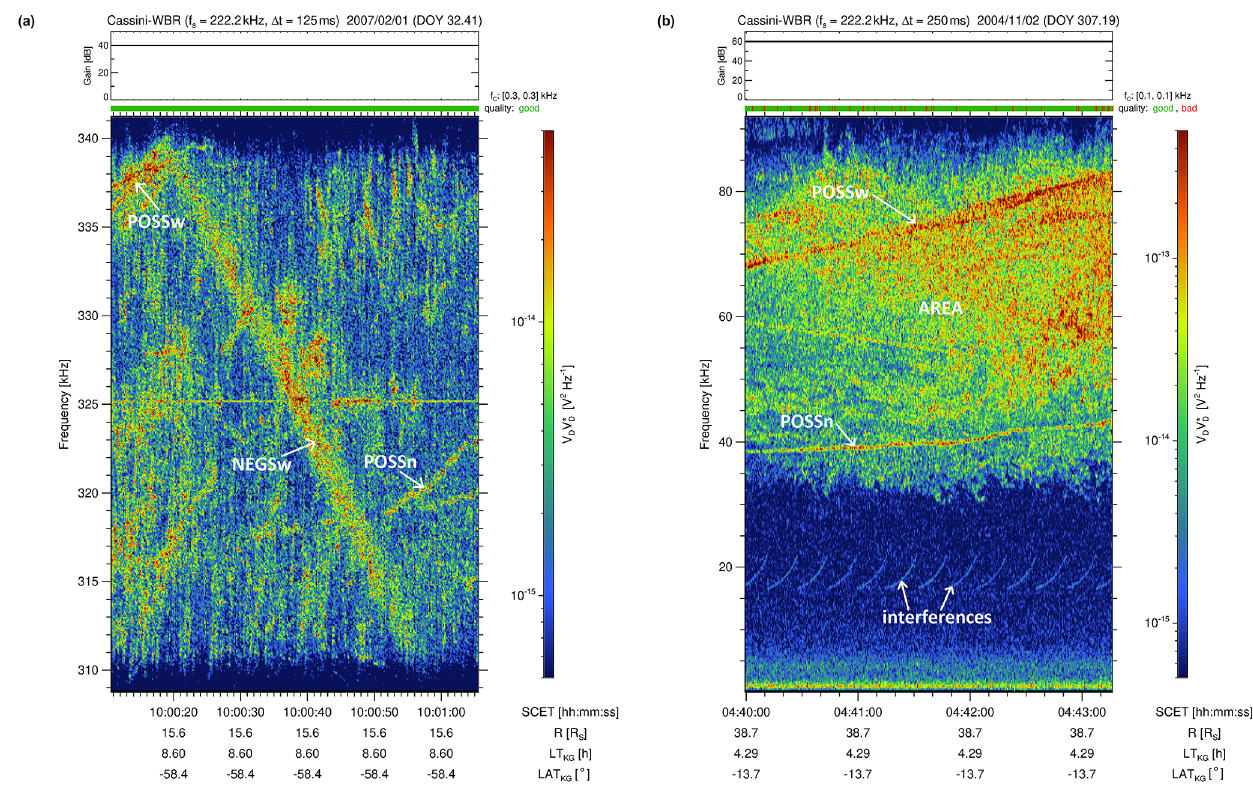
Figure 3. Fine structures of the classes NEGS (a) and POSS (b) show linear features of Saturn kilometric radiation with negative or positive slope,